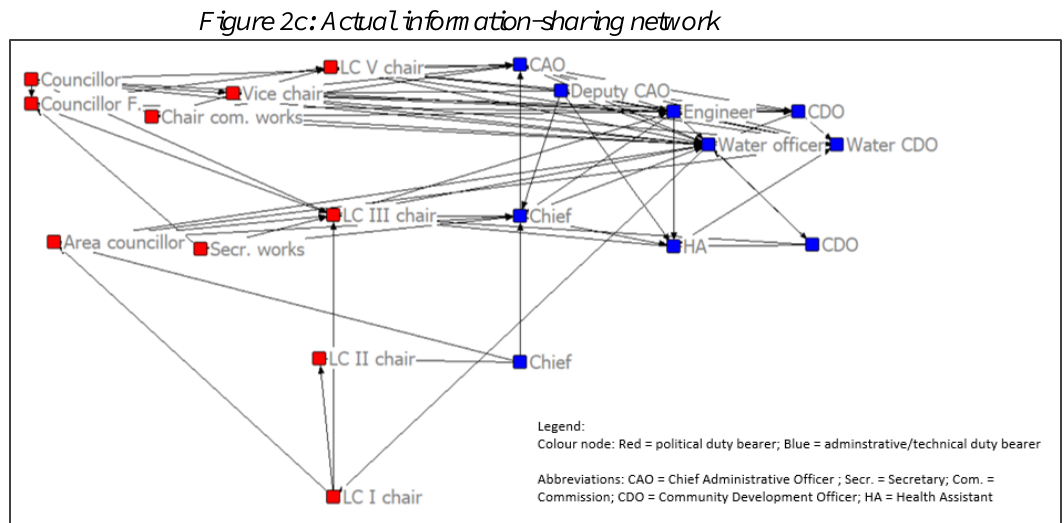
Figure 2c: Actual information-sharing